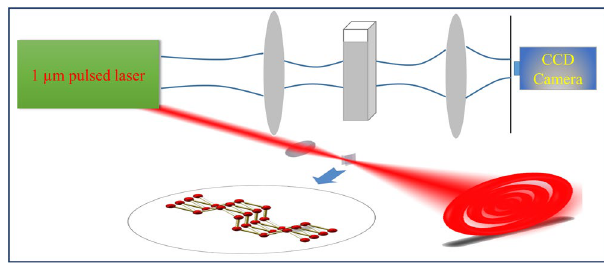
Figure 2. Experimental schematic diagram for SSPM experiment.